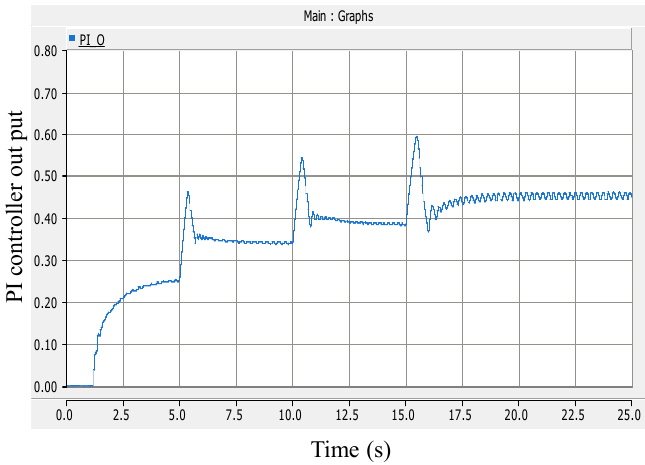
Figure 22. PI controller output for power control.